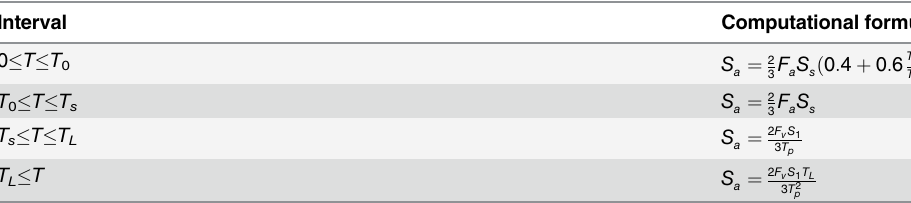
Table 1. Spectral response acceleration calculation